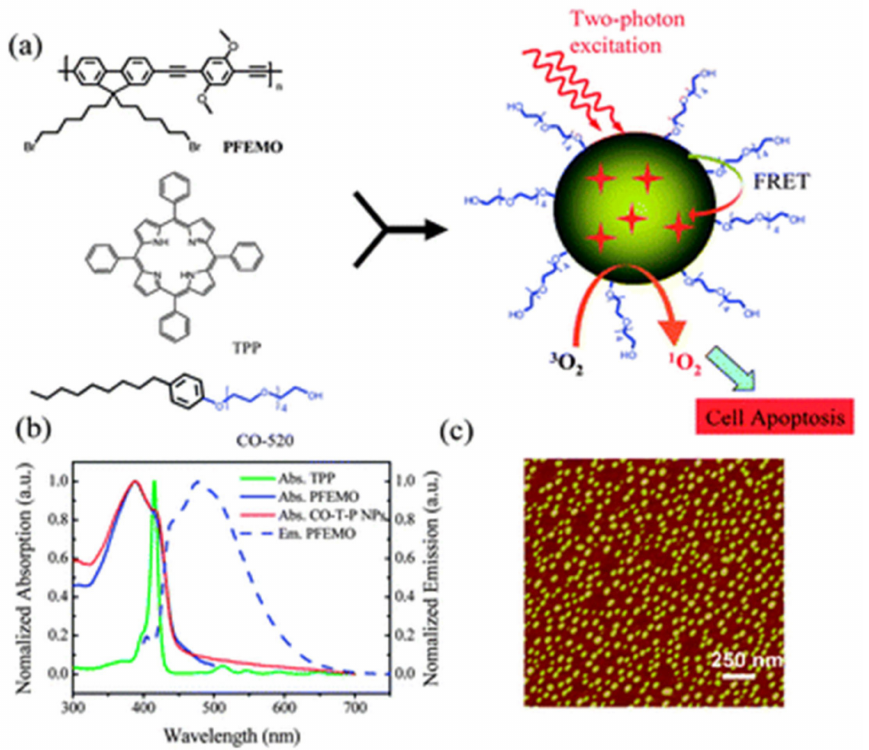
Figure 4. ( a ) Scheme of the formation of conjugated polymer nanoparticles (CPNs) for two-photon photodynamic therapy (two-photon Photodynamic Therapy (2PE-PDT)), ( b ) normalized absorption spectra of TPP, PFEMO and resulting CPNs (solid lines), and emission spectra of PFEMO (dashed line), ( c ) AFM imaging of CPNs on a mica substation. Republished with permission of The Royal Society of Chemistry from [63]; permission conveyed through Copyright Clearance Center Inc.